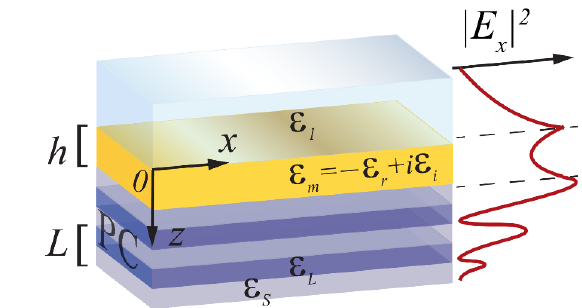
ε , ε , ε and ε , 1 m S L